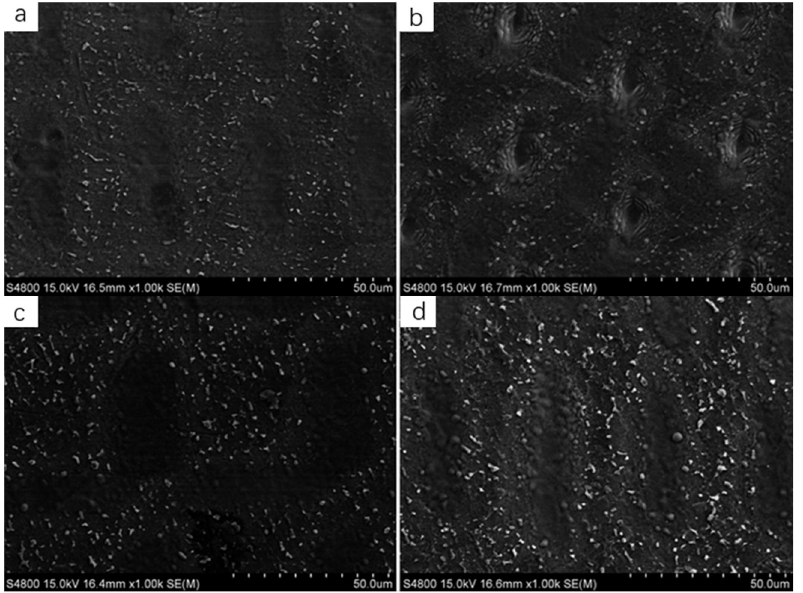
Figure 1. SEM images of surface morphology: ( a ) groove pattern; ( b ) micro-hole pattern; ( c ) direc- tional grain pattern; ( d ) stripe pattern. Abbreviations: SEM, scanning electron microscopy.